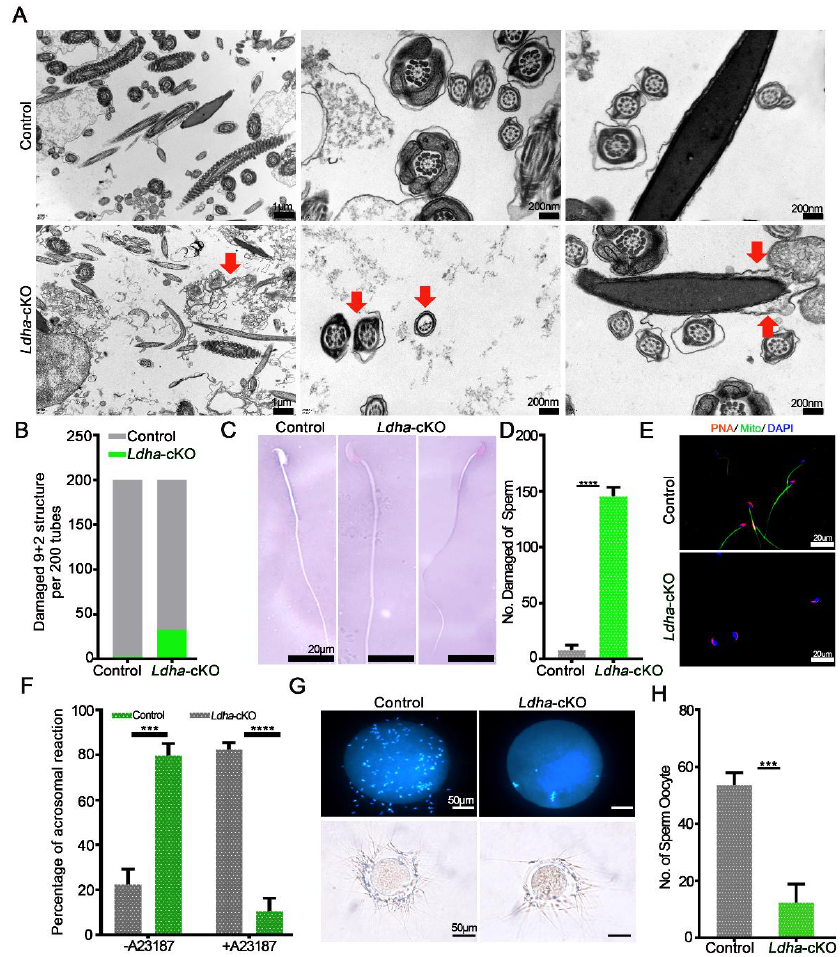
Figure 4. Ldha deletion in Sertoli cells changed the sperm structure. ( A ) Representative TEM images of sperm from the control and Ldha -cKO male mice. The red arrow indicates increased cellular debris in the damaged sperm plasma membrane and a damaged “9 + 2” structure. (Scale bars = 200 nm). ( B ) Rate of damage to the “9 + 2” structure of the sperm per 200 tubes in the control and Ldha -cKO male mice. ( C ) Representative images and the number ( D ) of eosin-aniline-black-stained sperm obtained from the male control mice and male Ldha -cKO mice at three months of age (scale bar = 20 μm). **** indicates a significant difference of p < 0.0001. n > 3. ( E ) Acrosome reactions and rate ( F ) induced by A23187 from the control and Ldha -cKO male mice. (Scale bars = 50 μm). At least 1000 sperm were counted for each genotype. *** indicates a significant difference of p < 0.001. **** indicates a significant difference of p < 0.0001. (G) Representative images and the number ( H ) of sperm binding to ZP from the control and Ldha -cKO male mice. (Scale bar = 50 μm) . At least 50 oocytes were counted for each genotype. *** indicates a significant difference of p < 0.001. Due to the abovementioned changes, the acrosome reactions that were induced by A23187 were completely different in the sperm from the Ldha -cKO animals compared to